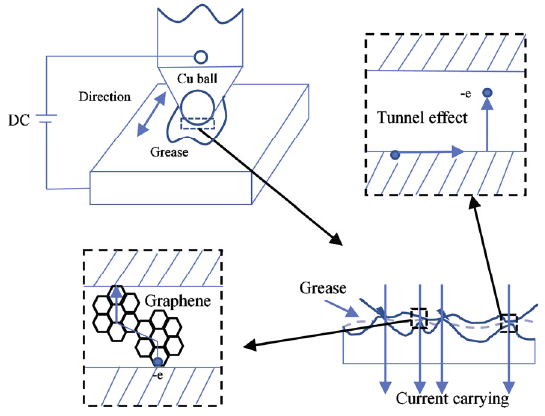
Fig. 2 Schematic diagram of electrical